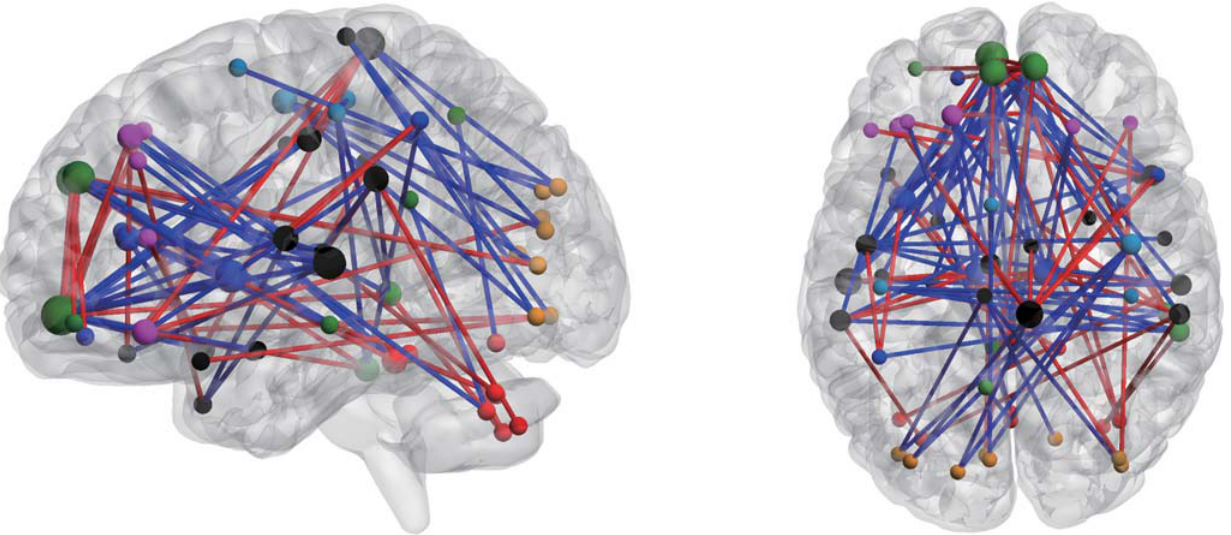
Fig 4. Consensus functional connections demonstrated in the left and top view. Regions are color-coded by category and size-coded by weight as in Fig 3. Red lines represent increased functional connections, and blue lines represent decreased functional connections.